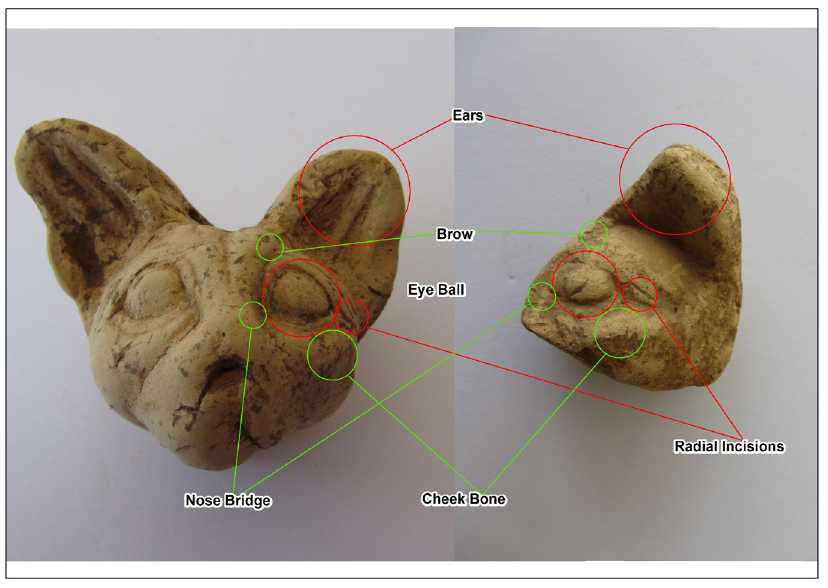
Figure 6. Comparison of moulded cat heads (HN 6080 Left and HN 6305 Right) indicating shared (green) and not shared (red) features.